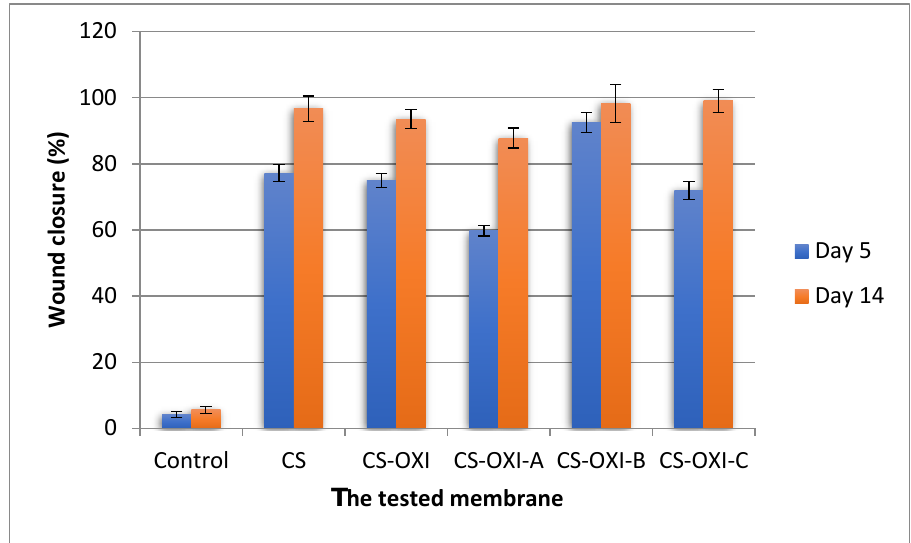
Figure 9. The wound closure (%) at the two different periods of time (on days 5 and 14).